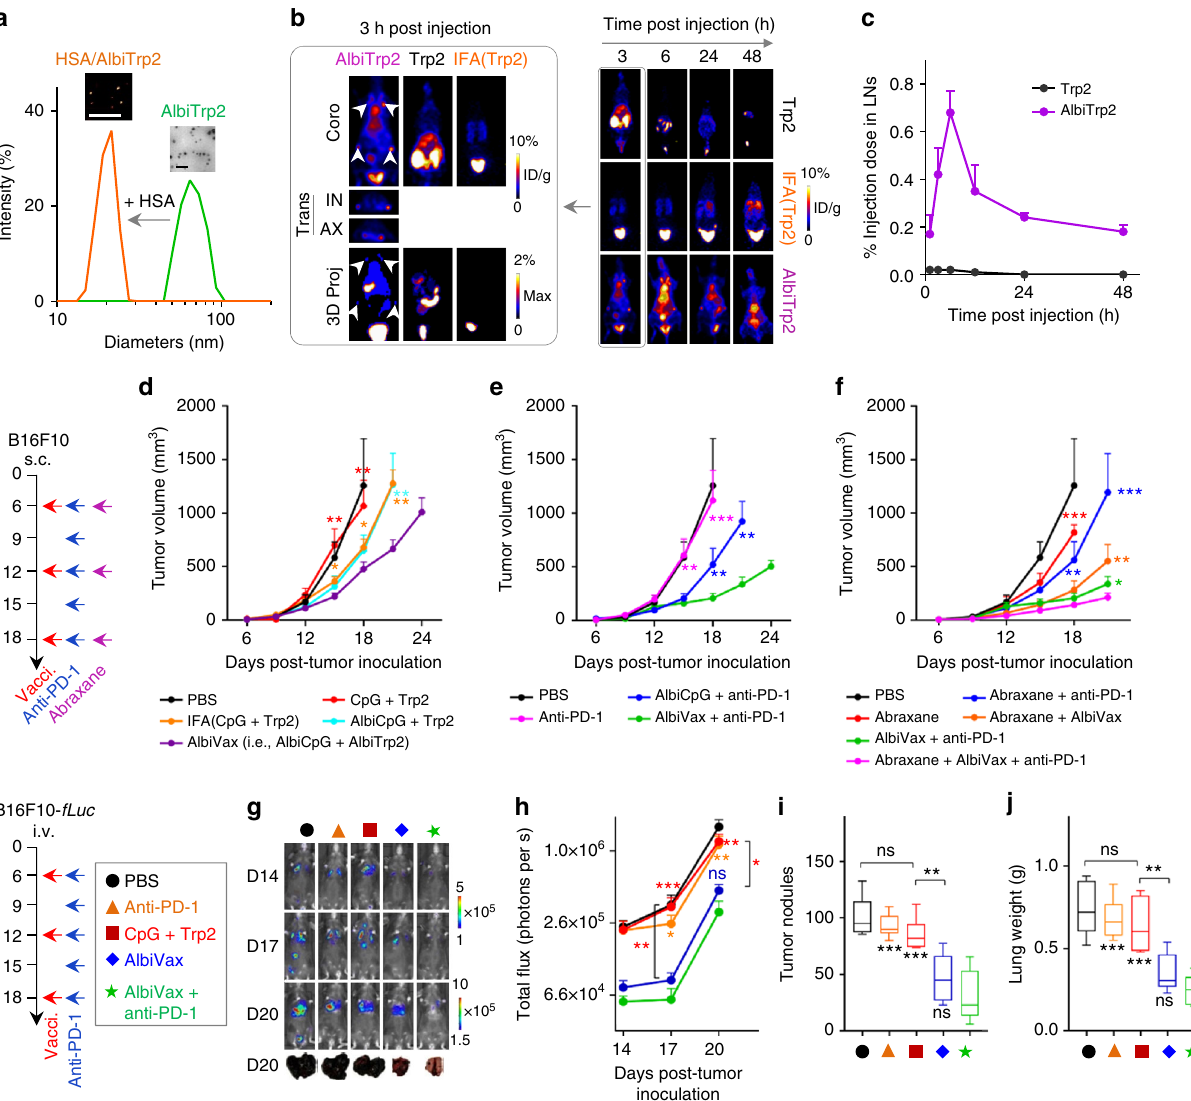
Fig. 5 Albumin/AlbiVax nanocomplexes for melanoma combination immunotherapy. a Transformation of AlbiTrp2 nanoparticles into albumin/AlbiTrp2 nanocomplexes in the presence of HSA (molar ratio of HSA: albumin = 1:1). Insets: an AFM image (left) and a TEM image showing the corresponding nanoparticles. Scale bars: 200 nm. b Representative coronal, transverse, and 3D projection of PET images at 3 h post injection (left), and representative coronal PET images at 3, 6, 24, and 48 h post s.c. injection of AlbiTrp2, free Trp2, and IFA(Trp2) at the tail base of FVB mice. (Dose: 4.4 – 5.5 Mbq.) c Quanti fi cation of albumin/AlbiTrp2 nanocomplexes and Trp2 in draining LNs (IN + AX). White arrows mark LNs. d – f B16F10 tumor growth after treatment with AlbiVax ( d ), double combination of albumin/AlbiVax nanocomplexes and anti-PD − 1 ( e ), and triple combination of albumin/AlbiVax nanocomplexes, anti-PD-1, and Abraxane ( f ). C57BL/6 mice were s.c. inoculated with 3 × 10 5 B16F10 cells, treated with AlbiVax (2 nmol CpG equivalents + 20 µ g AlbiTrp2) (day 6, day 12, and day 18), anti-PD-1 every 3 days from day 6 for fi ve times (200 µ g), and Abraxane on day 6, day 12, and day 18 (20 mg kg − 1 ). g – j C57BL/ 6 mice were i.v. injected with 1 × 10 5 B16F10- fLuc cells, treated with AlbiVax (2 nmol CpG equivalents + 20 µ g AlbiTrp2) on day 6, day 12, and day 18 and anti-PD-1 (200 µ g) every 3 days from day 6 for six times. g Representative bioluminescence images on day 14, day 17, and day 20, and photographs of lungs on day 20. i Quanti fi ed bioluminescence intensities of lungs. i , j Numbers of tumor nodules ( i ) and lung weights ( j ) on day 20. Data show mean ± s.e. m. of two – three independent experiments. *** p < 0.001, ** p < 0.01, * p < 0.05, ns not signi fi cant ( p > 0.05) by one-way ANOVA with Bonferroni elevated frequency of peripheral SIINFEKL + CD8 + CTLs (Supple- therapeutic outcome of AlbiCpG + OVA, depletion of CD8 + T cells nearly completely neutralized its ef fi cacy, suggesting the mentary Fig. 27d). Moreover, no morbidity or toxicity was central role of CD8 + CTLs in AlbiVax-based immunotherapy observed in AlbiVax-treated mice (Supplementary Fig. 27e). (Fig. 4h). To study the Ag speci fi city of immunotherapy, C57BL/6 mice were s.c. inoculated with 3 × 10 5 EL4 cells (OVA − ) on the left shoulder and 3 × 10 5 EG7.OVA on the right shoulder. Treatment with AlbiCpG + OVA again regressed 4/6 EG7.OVA tumors, whereas EL4 tumor progression was barely affected (Supplementary Fig. 27b, c), thus con fi rming the Ag speci fi city of outcome can be improved by potentiating antitumor immunity. A AlbiVax-mediated immunotherapy. Again, AlbiCpG + OVA